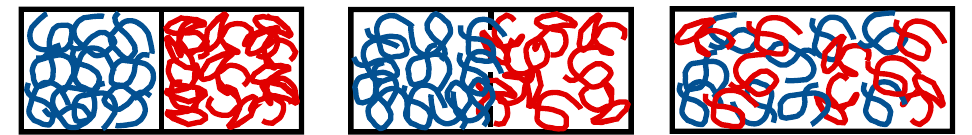
Figure 1. Schematic depiction of the welding phenomenon over time until the disappearance of the interface.